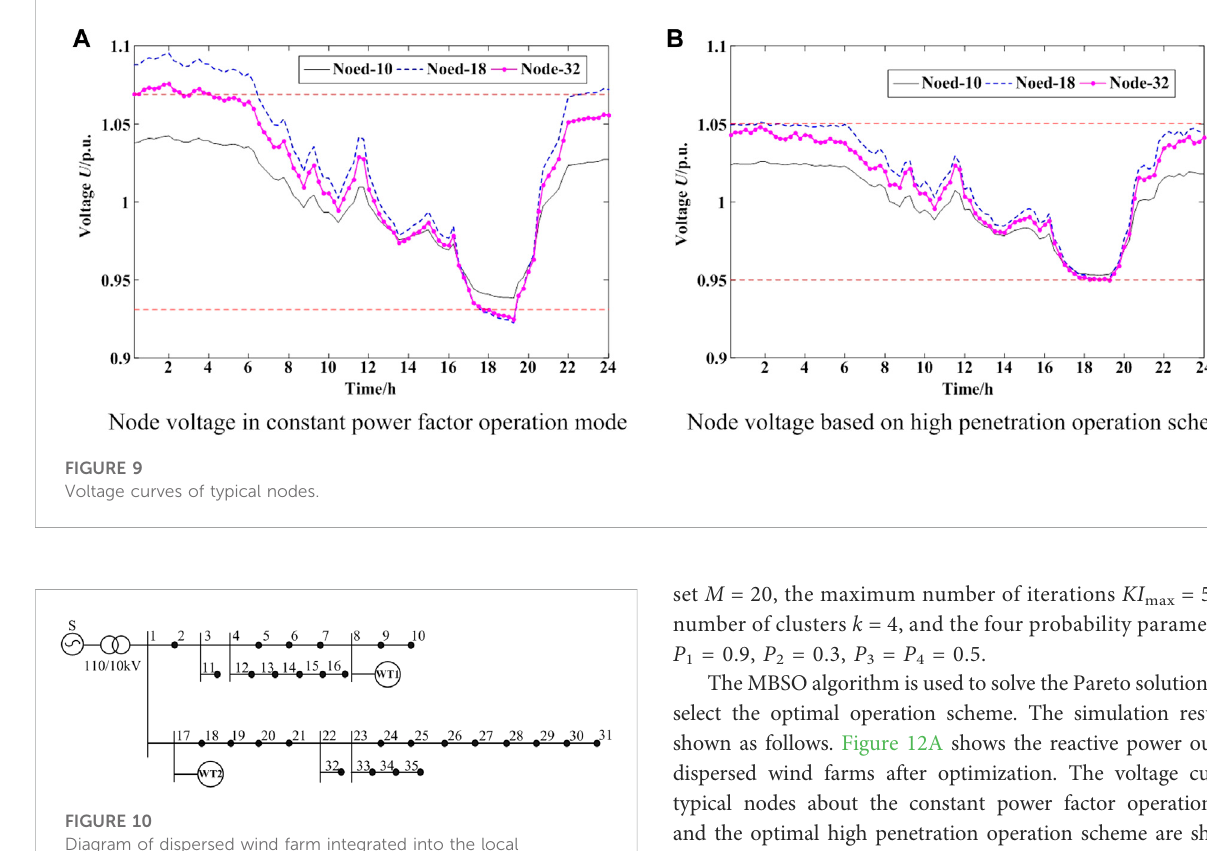
FIGURE 10 Diagram of dispersed wind farm integrated into the local distribution network.